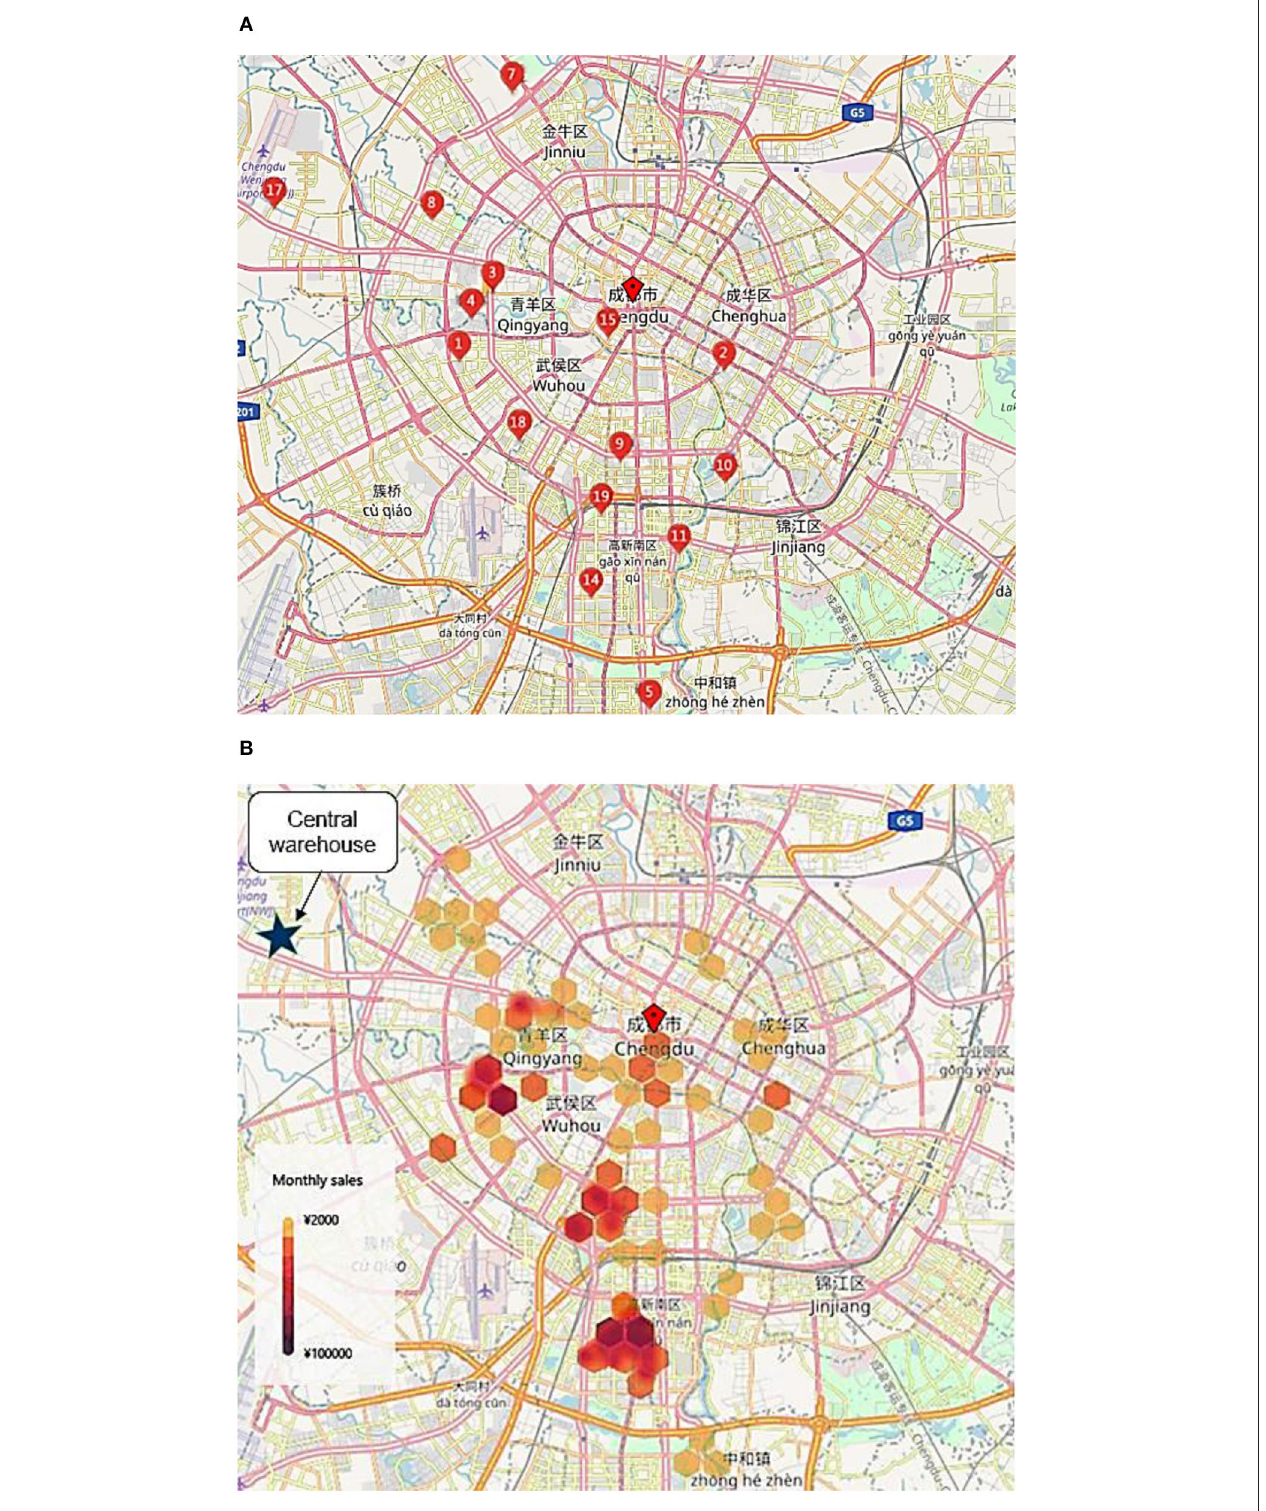
FIGURE 2 | (A) Store location of the retailer. (B) Heat map of sales distribution. Location 17 is the central warehouse. The other locations are offline shops in city C.